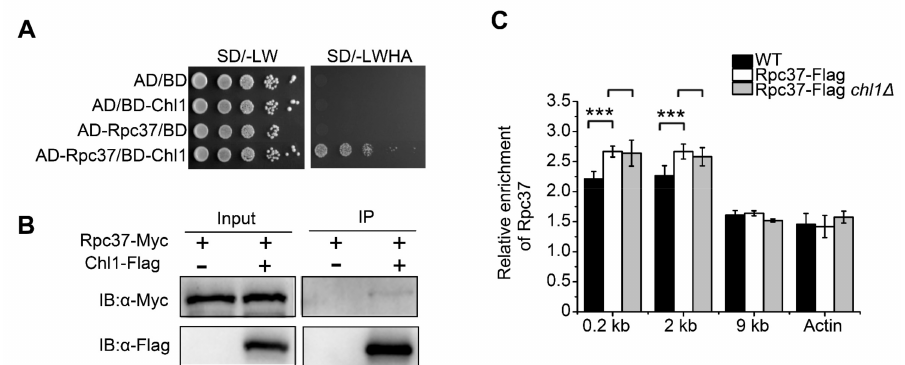
Figure 2. Rpc37 recruits Chl1 to DSB sites by directly interacting with them: ( A ) Gal4 DNA activation (GAL4-AD) and Gal4 DNA binding (GAL4-BD) domains were fused to Rpc37 and Chl1, respectively. The indicated plasmids were co-transformed into AH109 yeast strains; colonies on SD/-Leu-Trp media suggested successful transformation. Cells growing on SD/-Leu-Trp-His-Ade media implied reporter gene expression and an interaction between the two proteins; ( B ) Rpc37-Myc was expressed in cells, either alone or together, with Chl1-Flag, and the Chl1-Flag was immunoprecipitated with anti-Flag attached to agarose beads. The tagged proteins were detected by Western blotting; ( C ) ChIP analyses showed the level of Rpc37 at 0.2 kb, 2 kb, and 9 kb from the HO-induced DSB sites in the indicated strains. The data are presented as mean ± SEM, and three independent assays were performed. Statistical significance was evaluated using an unpaired t -test. ***, p < 0.001.